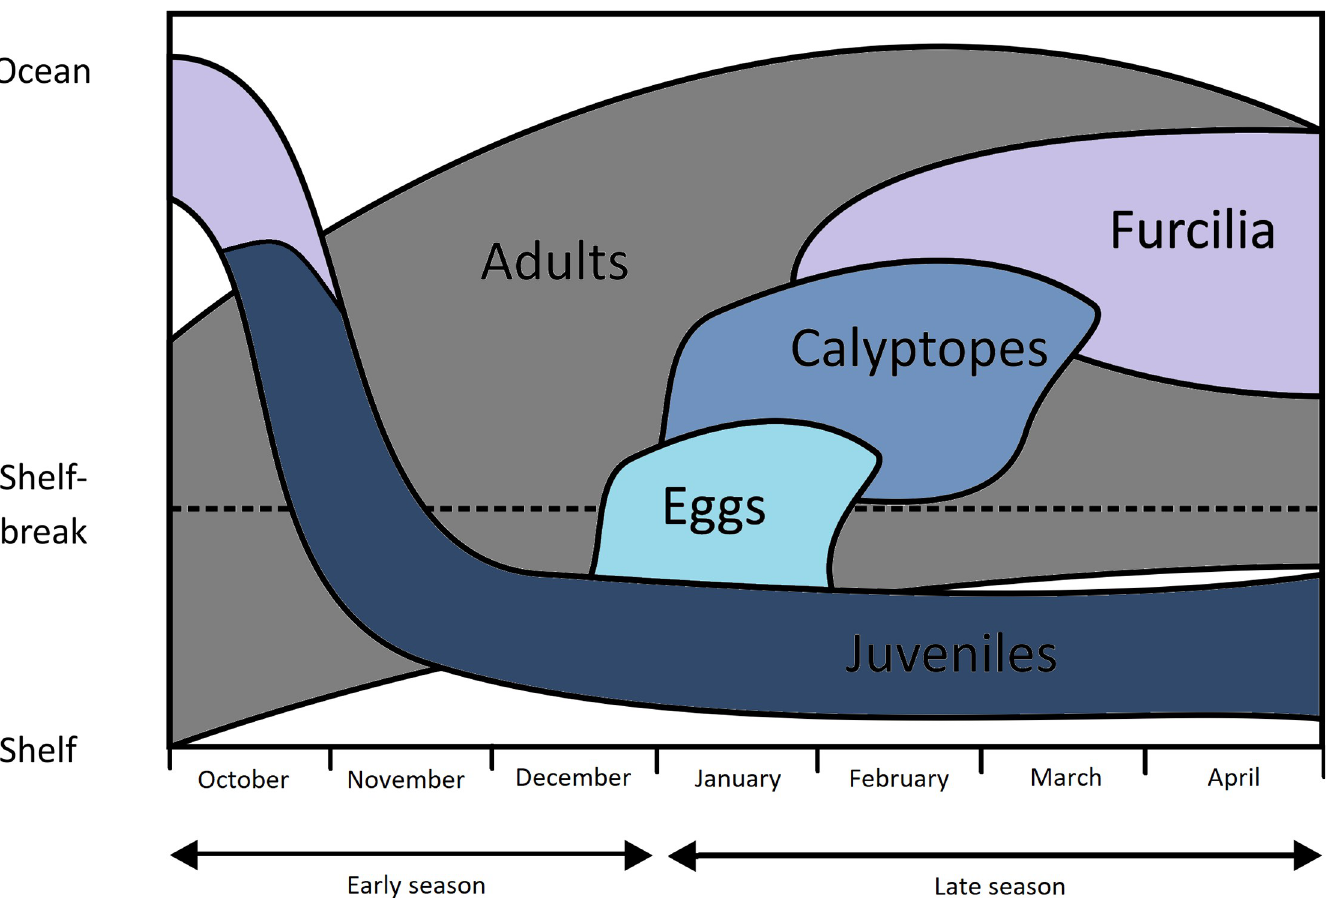
Fig 7. Schematic of seasonal change in onshelf—offshelf distributions of krill life stages. This illustration is based mainly on our Fig 5. The schematic portrays the main areas of the distribution relative to the shelf throughout the austral spring to autumn period. It builds on a schematic published in Fig 2.6 of [4], but includes the observed redistribution of juvenile krill from oceanic waters back to shelf waters throughout the austral spring. This schematic simply reports the changing distributions seen in our study and does not propose candidate mechanisms such as advection, migration or differential mortality.